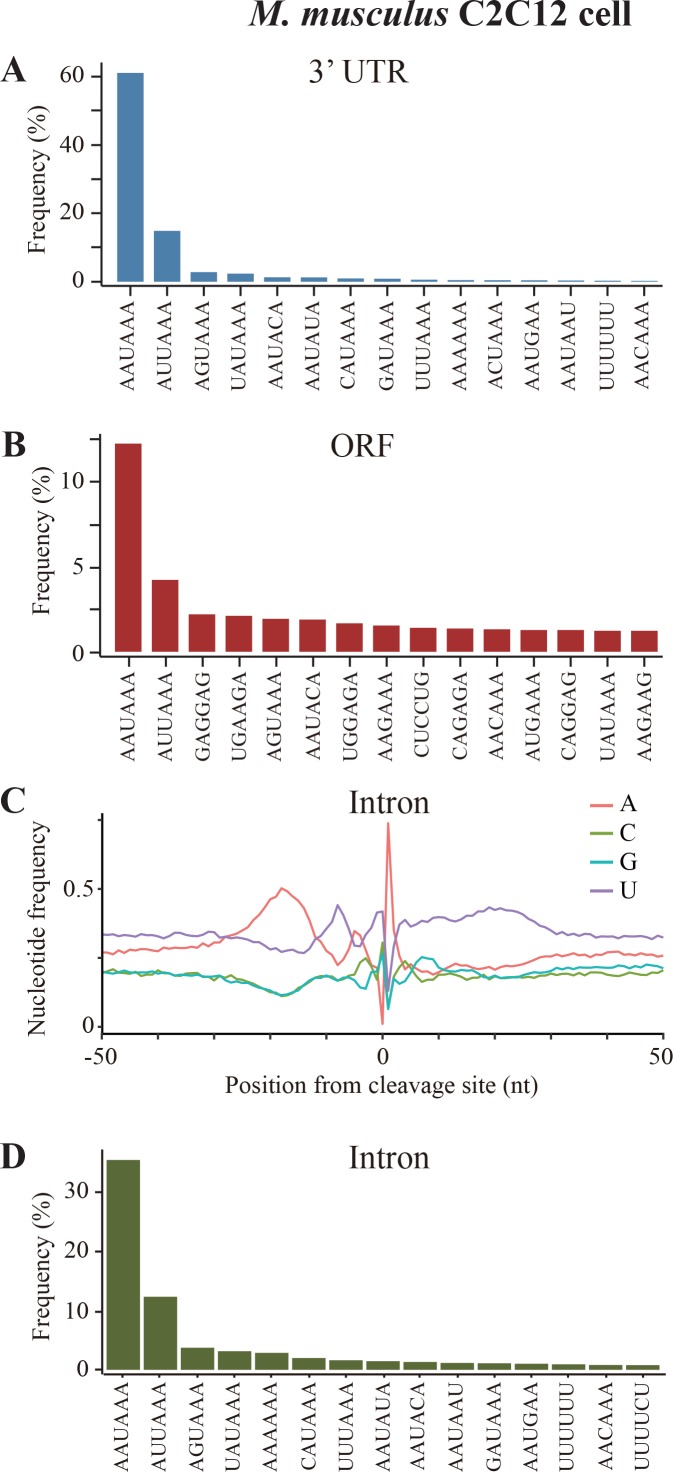
Sequence analyses of poly(A) sites in mouse C2C12 cells.(A) Top 15 most frequently used PAS motifs found in the A-rich element of 3’ UTR-PAS. (B) Top 15 most frequently used PAS motifs found in the A-rich element of 3’ ORF-PAS in mouse C2C12 cells. (C) Nucleotide sequence composition surrounding poly(A) sites in intron. (D) Top 15 most frequently used PAS motifs found in the A-rich element of 3’ Intron-PAS.